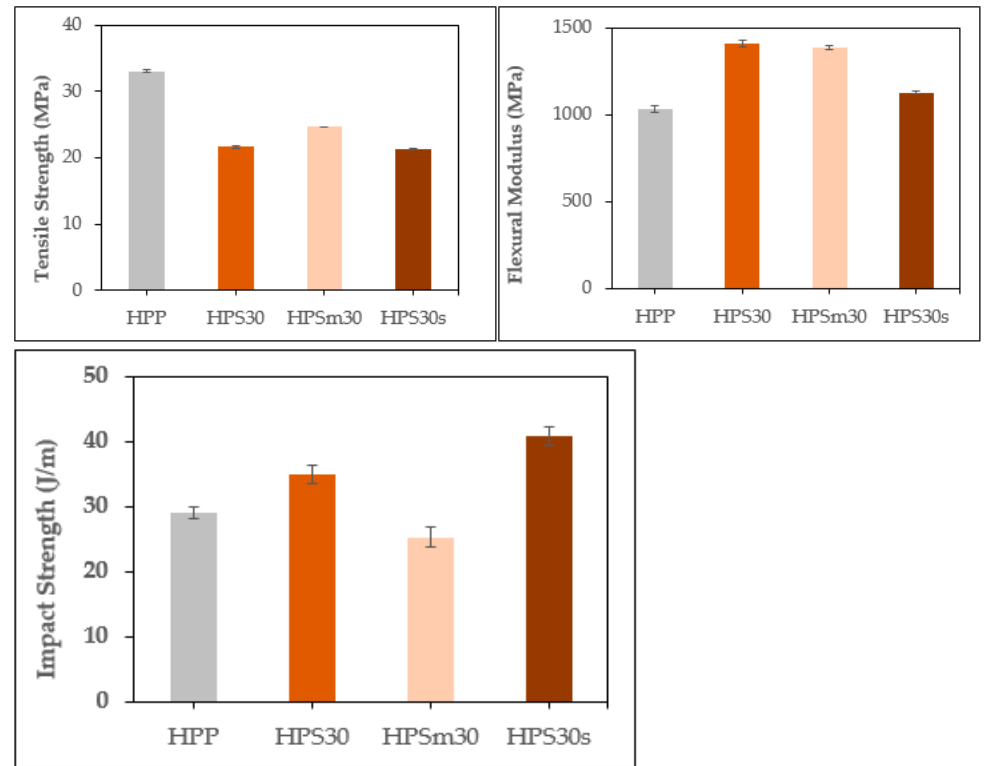
Figure 9. Mechanical properties of PP/SOC according to maleic anhydride-grafted polypropylene (MAPP) addition and SOC particle size.